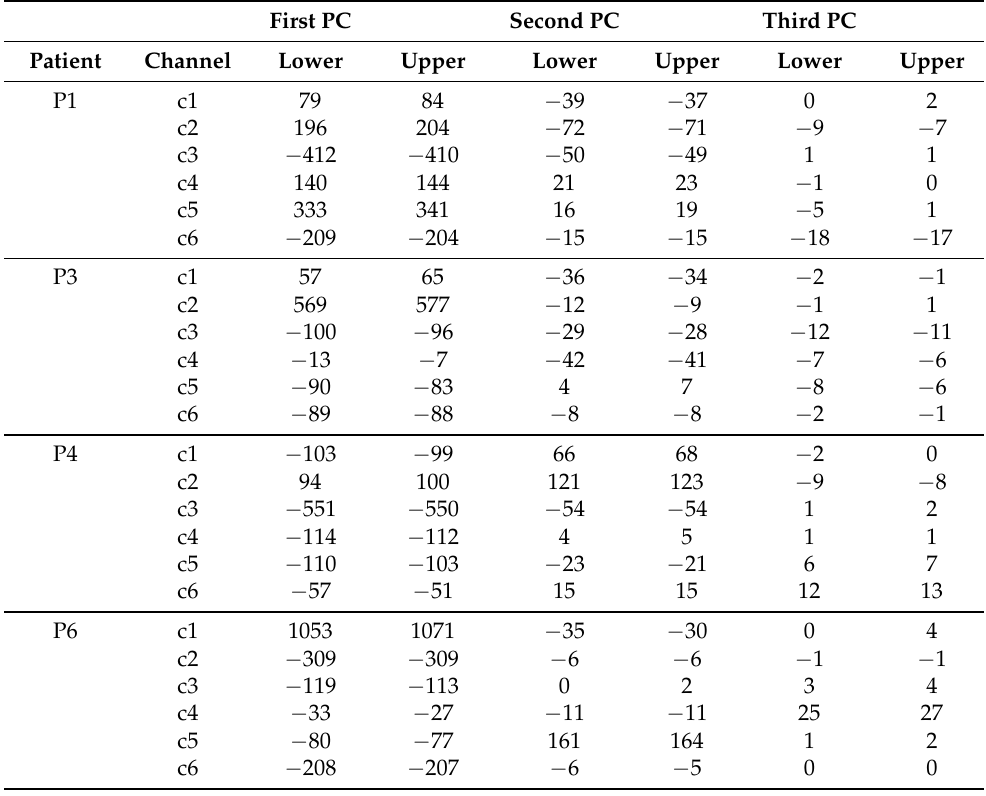
Table 1. The 95% confidence intervals for the mean value of extracted features by different patients and different channels for both interictal and ictal signals. The features are the principal component scores of DWT power spectra at the thousand scale. First PC Second PC Third